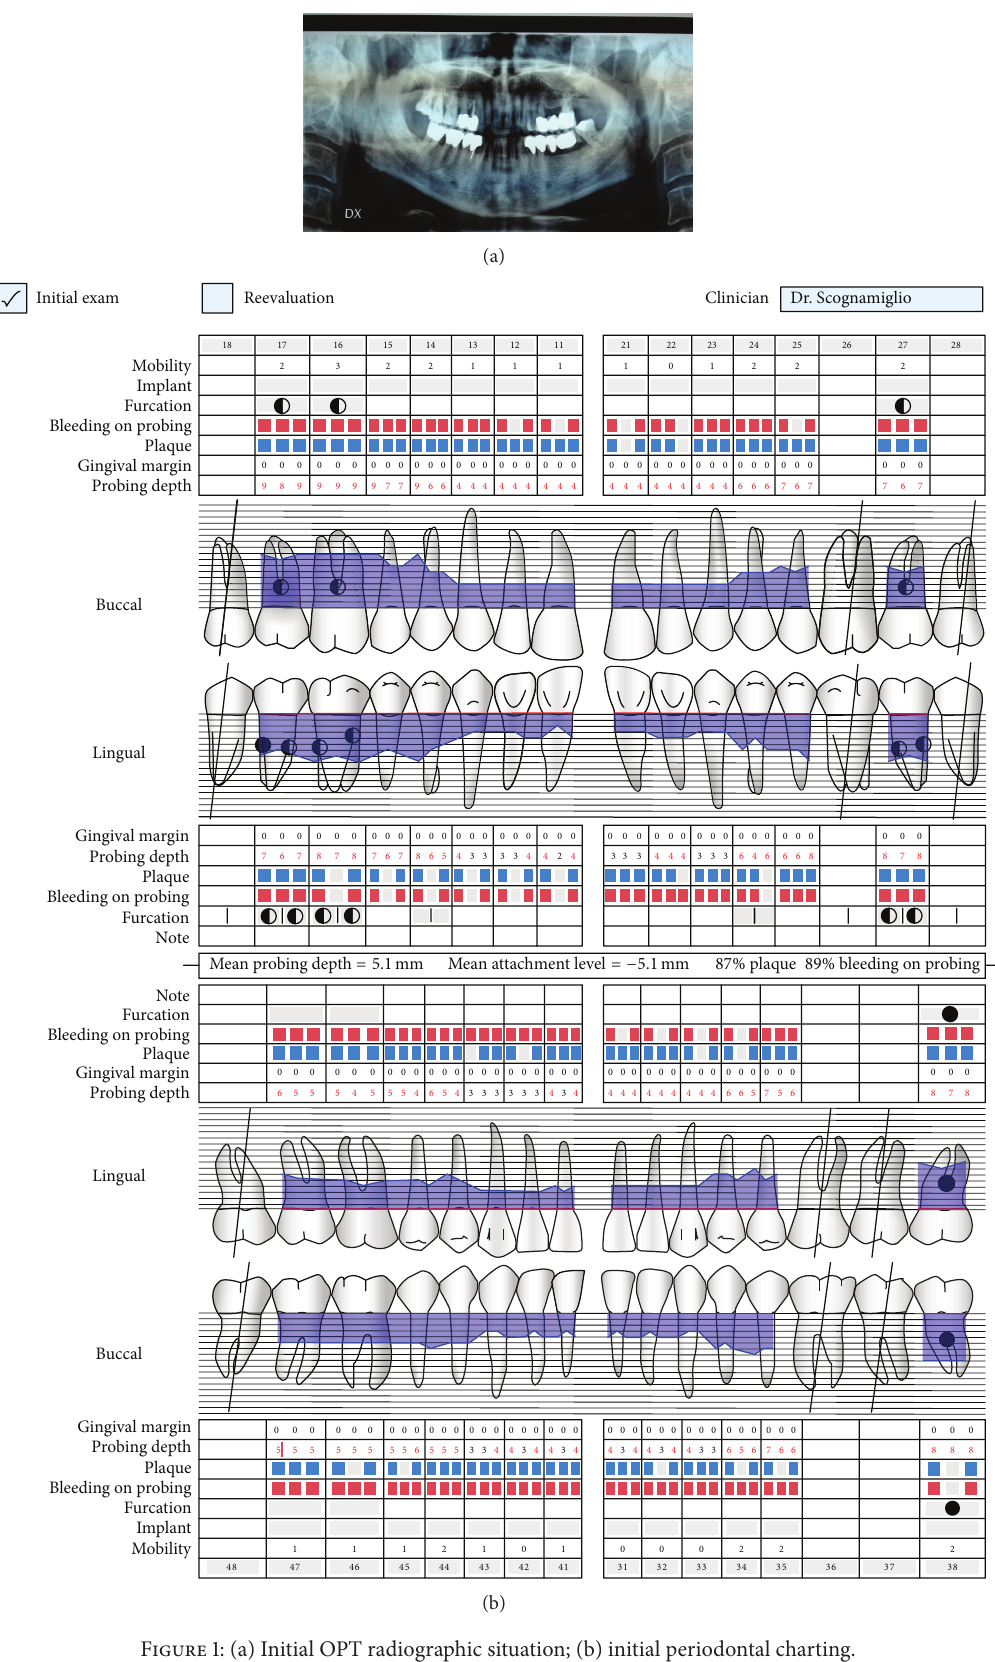
Figure 1: (a) Initial OPT radiographic situation; (b) initial periodontal